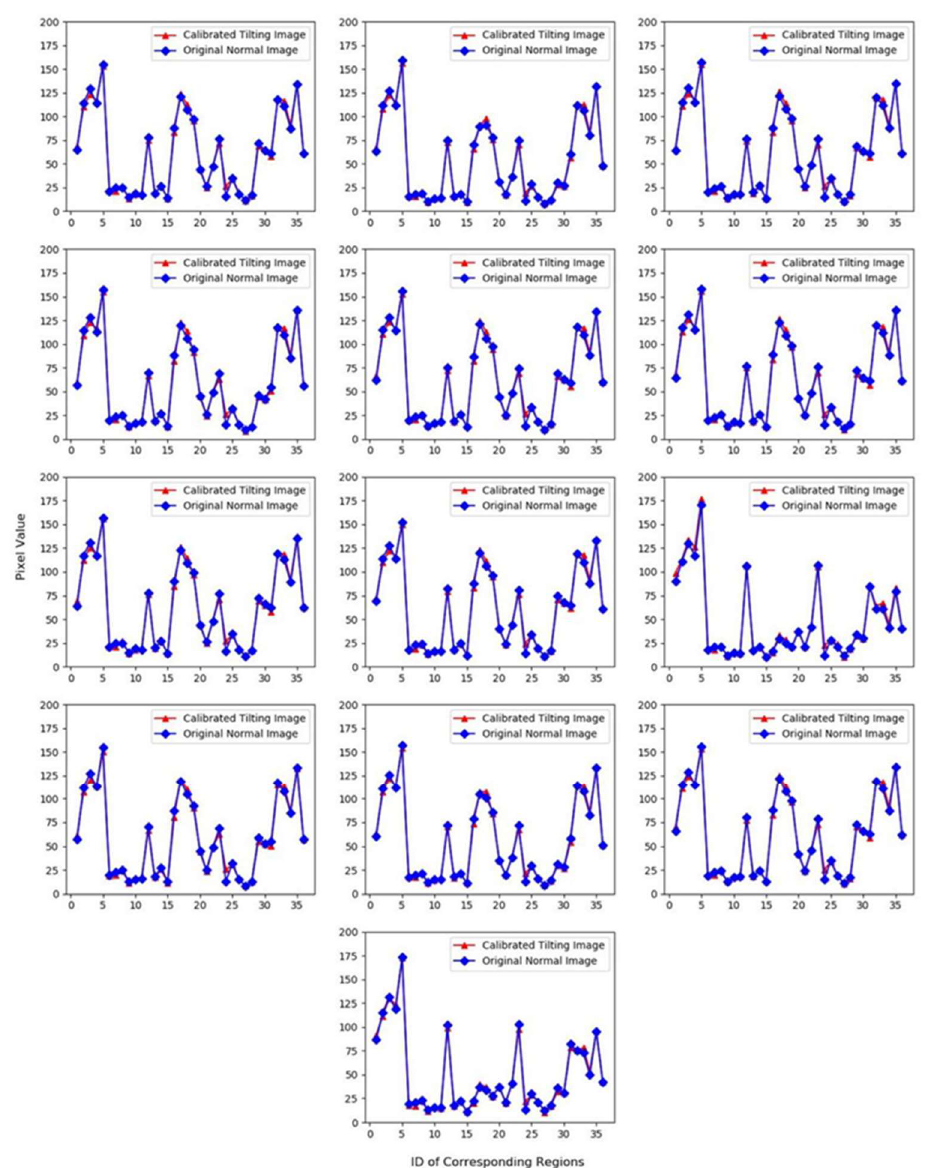
Figure 14. Comparisons maps of mean-value between the calibrated tilting image and the original normal image. normal